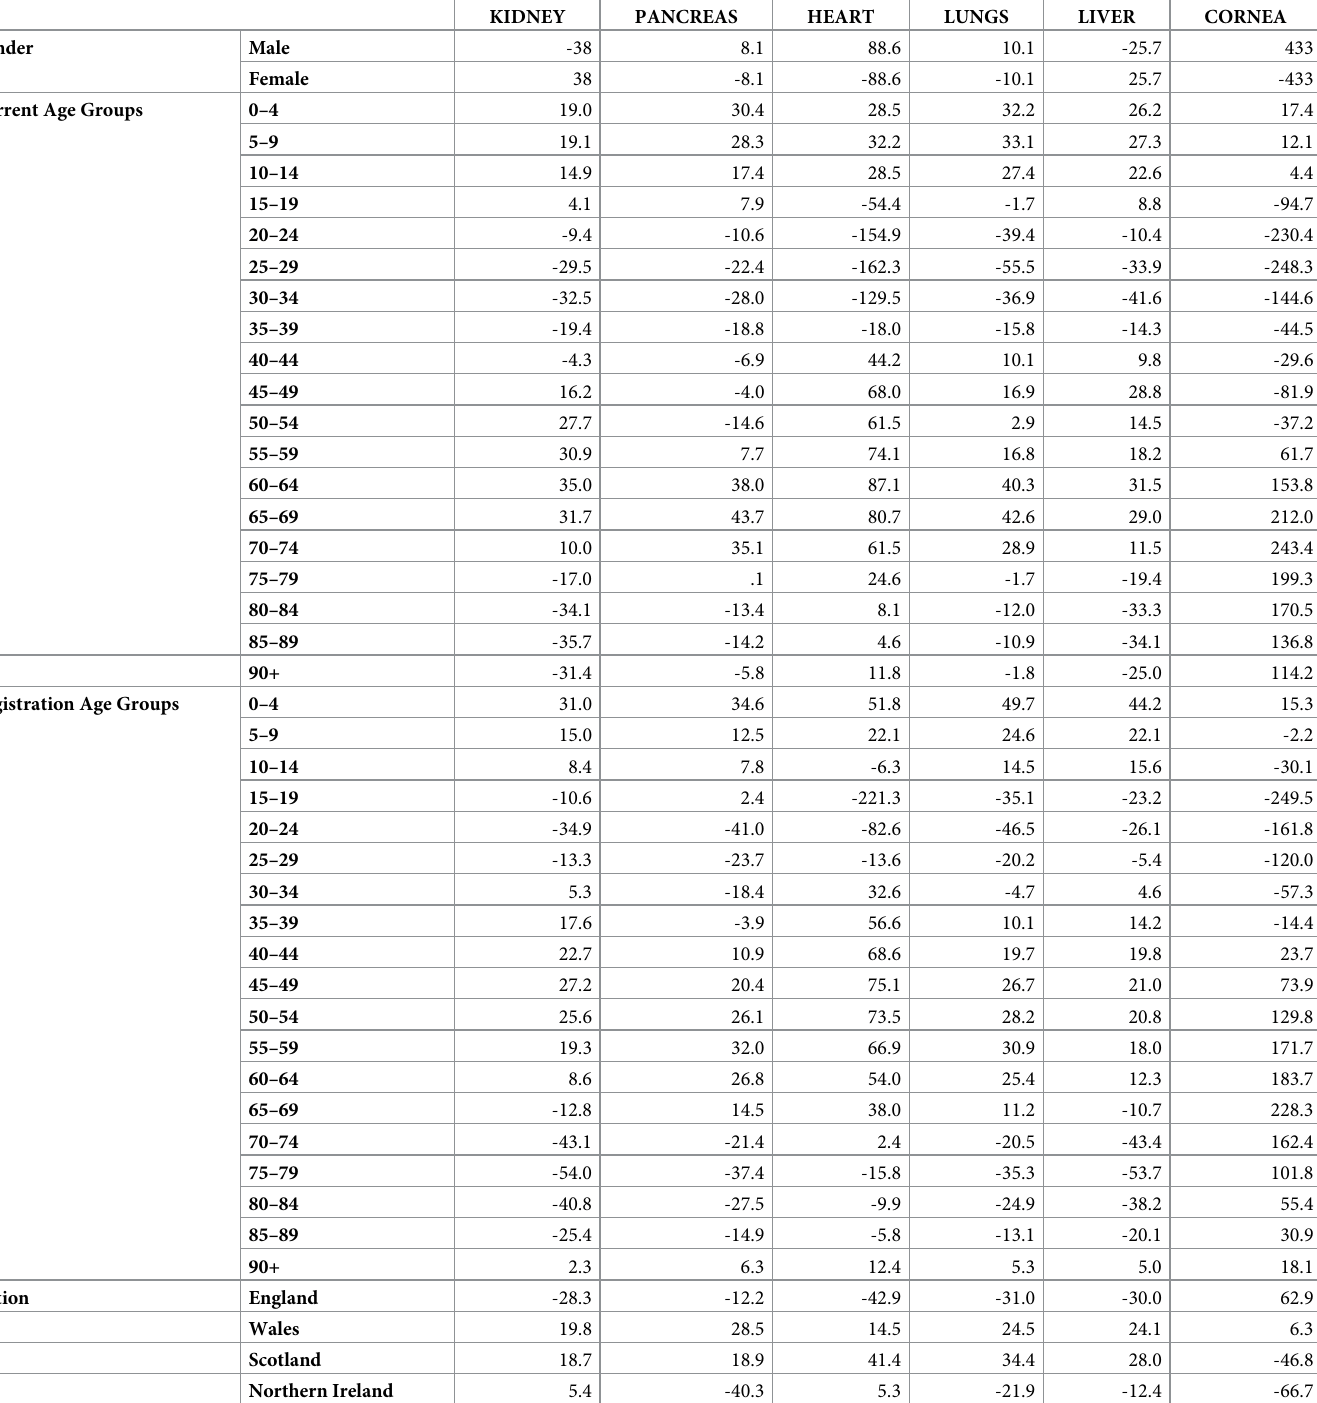
Table 6. Chi 22 test of independence adjusted residuals for saying yes to donating specific organs and age groups, gender and nation (analysed using dataset 1 – March 2017). KIDNEY PANCREAS HEART LUNGS LIVER CORNEA Gender Male